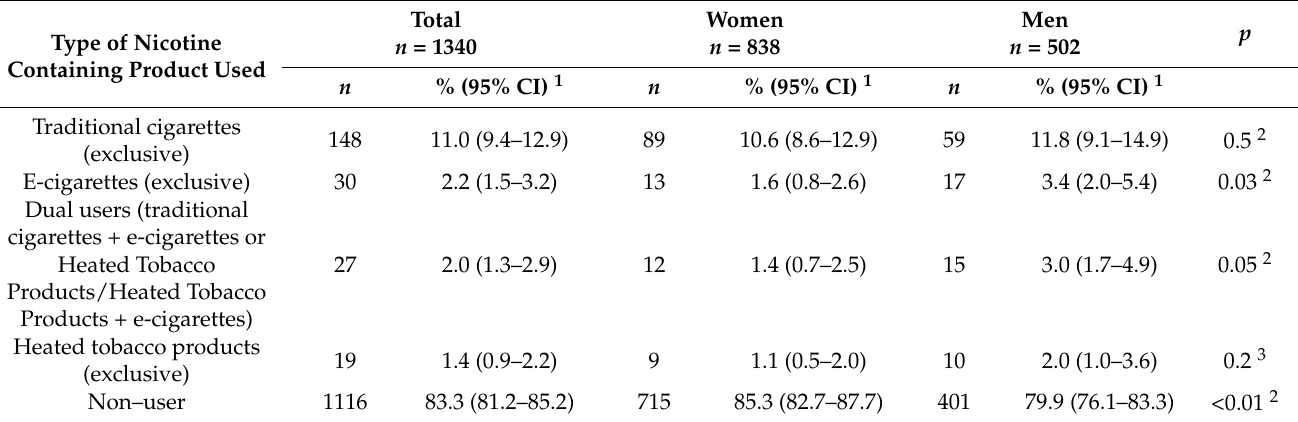
Table 1. Difference between men and women according to their nicotine product